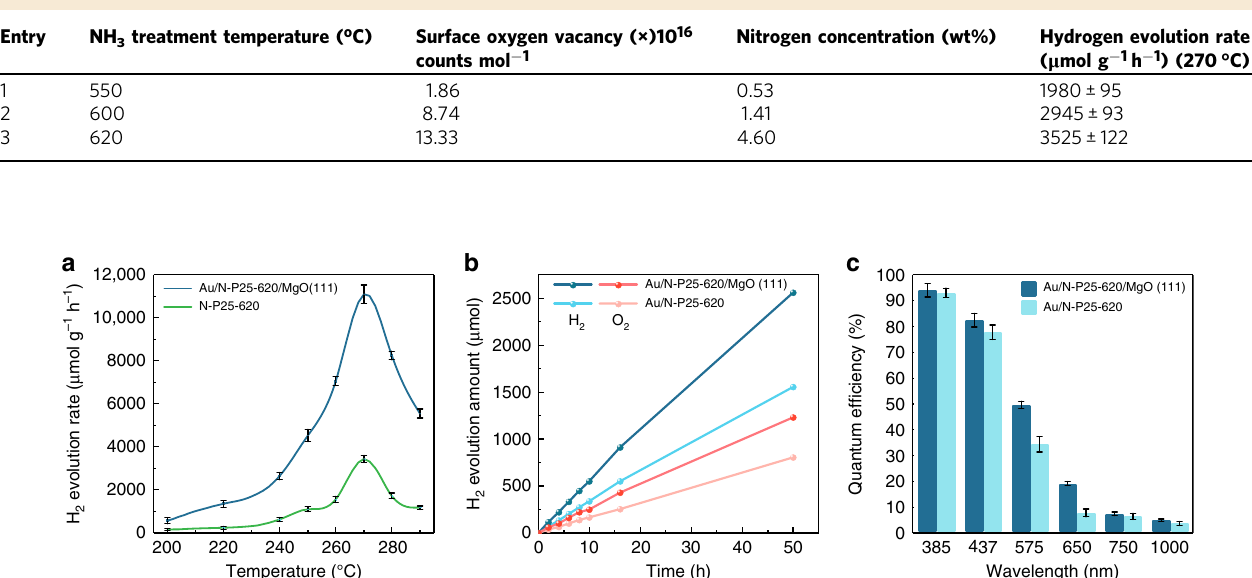
Fig. 2 Photocatalytic water-splitting reaction activity tests. a Photocatalytic activities of N-P25-620 and Au/N-P25-620 with MgO (111) at different temperatures. b Stable stoichiometric decomposition of water to 2:1 H 2 /O 2 with no sacri fi cial reagent over Au/N-P25-620 with and without MgO (111) at a constant rate for 50 h. Typically, 5 mg of Au/N-P25-620 was added to 10 mL of Milli-Q H 2 O in a 25-mL stainless-steel autoclave equipped with quartz windows under vigorous magnetic stirring, and Ar gas was used as the inert gas. Then the autoclave was heated up to designated temperatures. c QE of Au/N-P25-620 with and without MgO (111) by using incident wavelengths of 385, 437, 575, 620, 750 and 1000nm, respectively (UV – vis spectra of fi lters are shown in Supplementary Fig. 9). QE measurements were carried out with a similar procedure as that stated before. The reaction system was then irradiated by a 300-W xenon lamp through quartz windows by using the corresponding band-pass fi lters. Error bars indicate the standard deviation